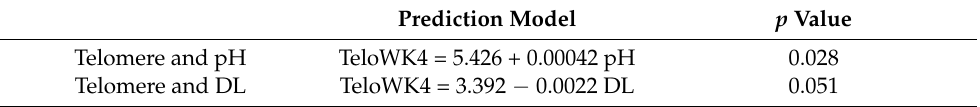
Table 11. The prediction model equations of telomere length with pH and DL.